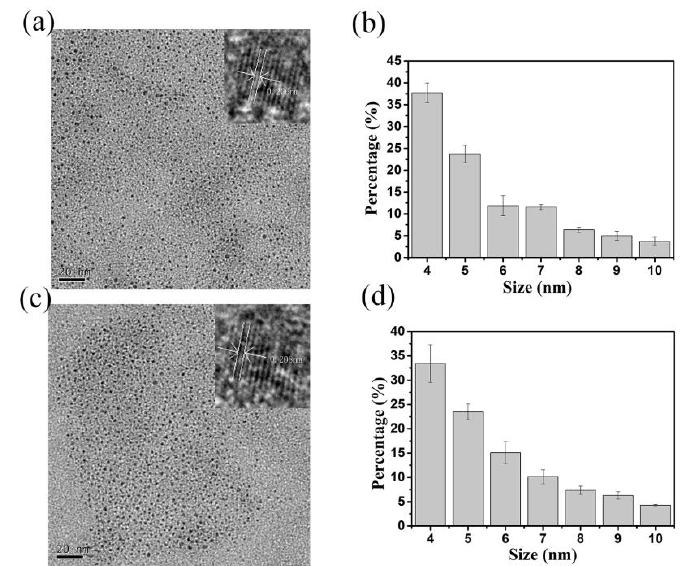
Figure 1. Transmission electron microscopy (TEM) image of the nitrogen-doped carbon quantum dots (N-CQDs). ( a ) orange peel nitrogen carbon doped quantum (ON-CQDs), ( c ) watermelon peel carbon quantum dots (WN-CQDs); (inset: high-resolution transmission electron microscopy (HRTEM) of the N-CQDs); ( b ) and ( d ) shows the size distribution of the carbon dots corresponding to ( a ) and ( c ), respectively.